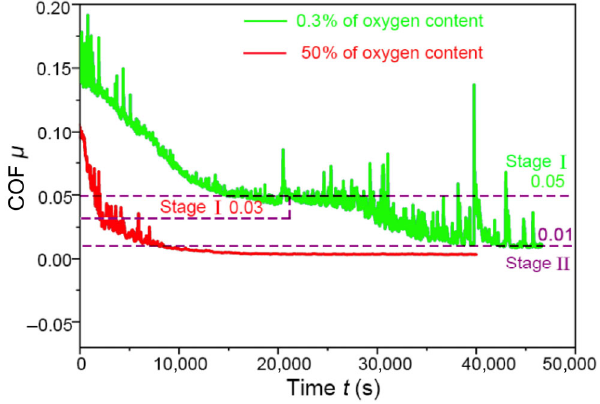
Fig. 2 COF vs. sliding time of the steel/steel interfaces lubricated with EPBD-0201 solution in the surrounding environments with ~0.3 and ~50 wt% O 2 contents. The applied load F was 2 N, and the sliding speed v was 0.5